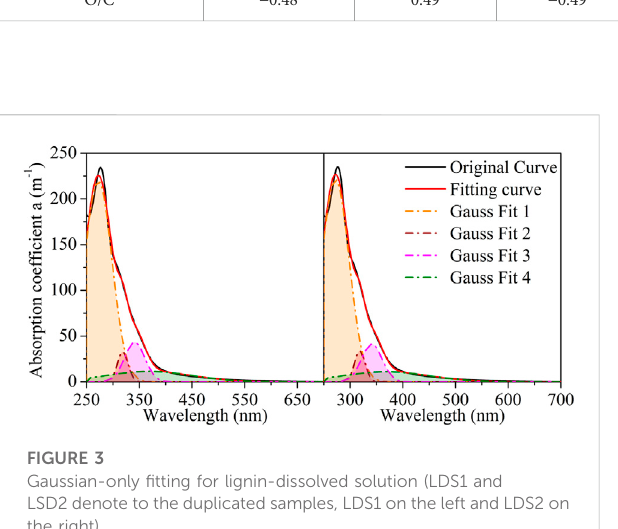
FIGURE 4 Gaussian-only fi tting for humic acid-dissolved solution (HADS1 and HAD2 denote to the duplicated samples, HADS1 on the left and HADS2 on the